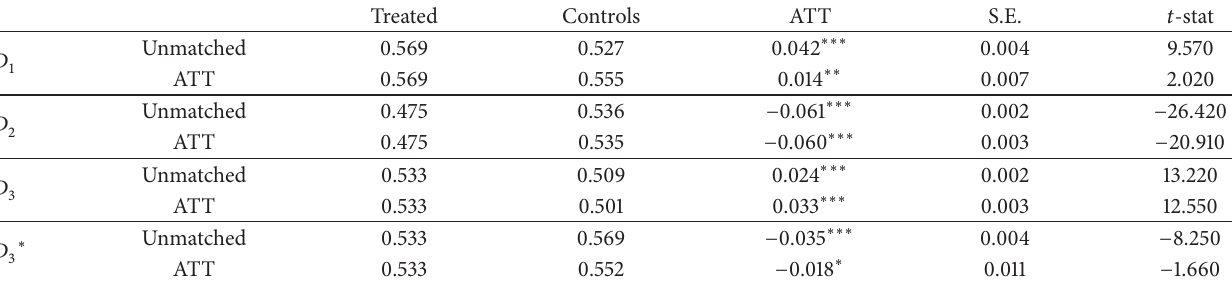
Table 4: Average treatment effects (matching